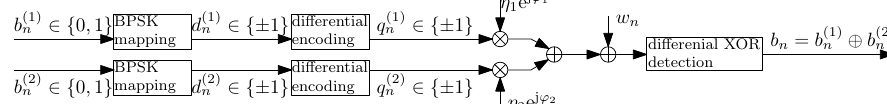
Figure 2. The system model for differential